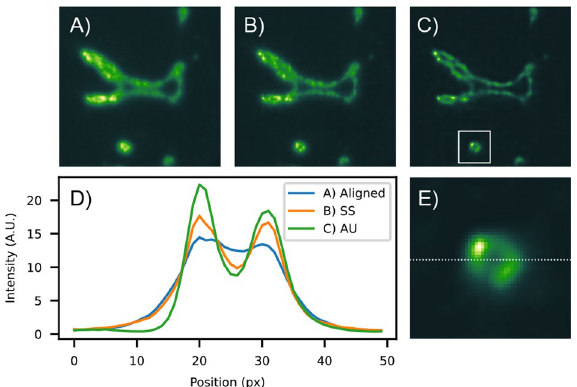
Figure 4. Tomographic slice of the cropped volume. ( A ) Aligned mean (standard reconstruction). ( B ) Reconstruction using SS. ( C ) Reconstruction using AU. ( D ) Profile plot along the dashed line in panel ( E ) for the three cases. ( E ) Detail of the small opening for